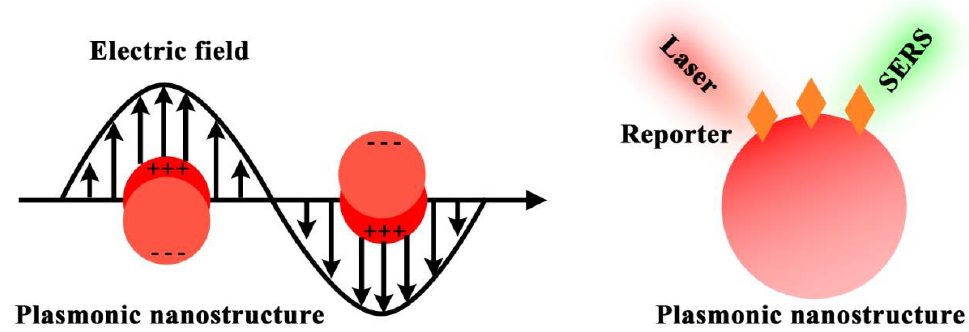
Figure 1. Schematic illustration of SERS nanotag enabled highly sensitive and multiplexed detec-